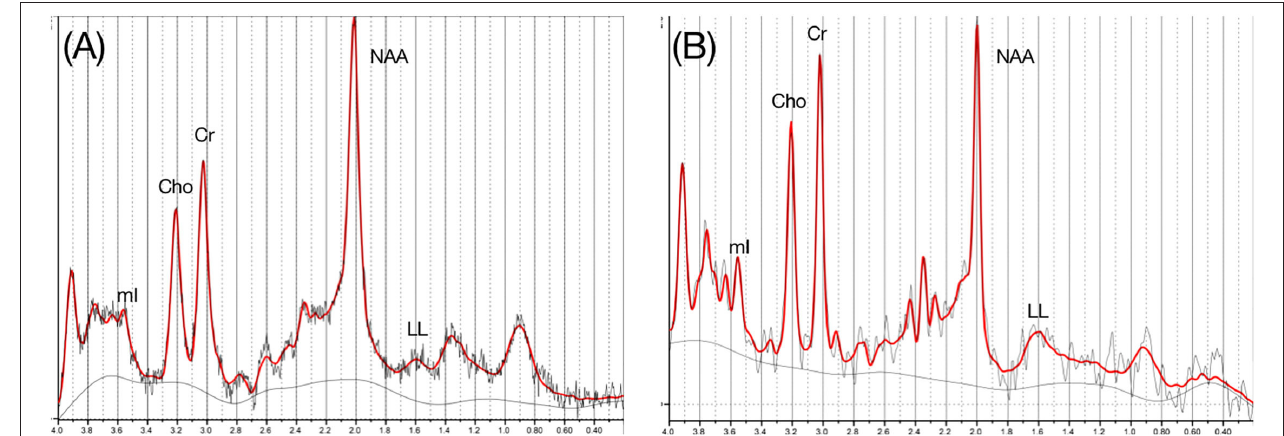
FIGURE 2 | 1 H-MRS spectra obtained from a control subject (A) and a patient with PD (B) .